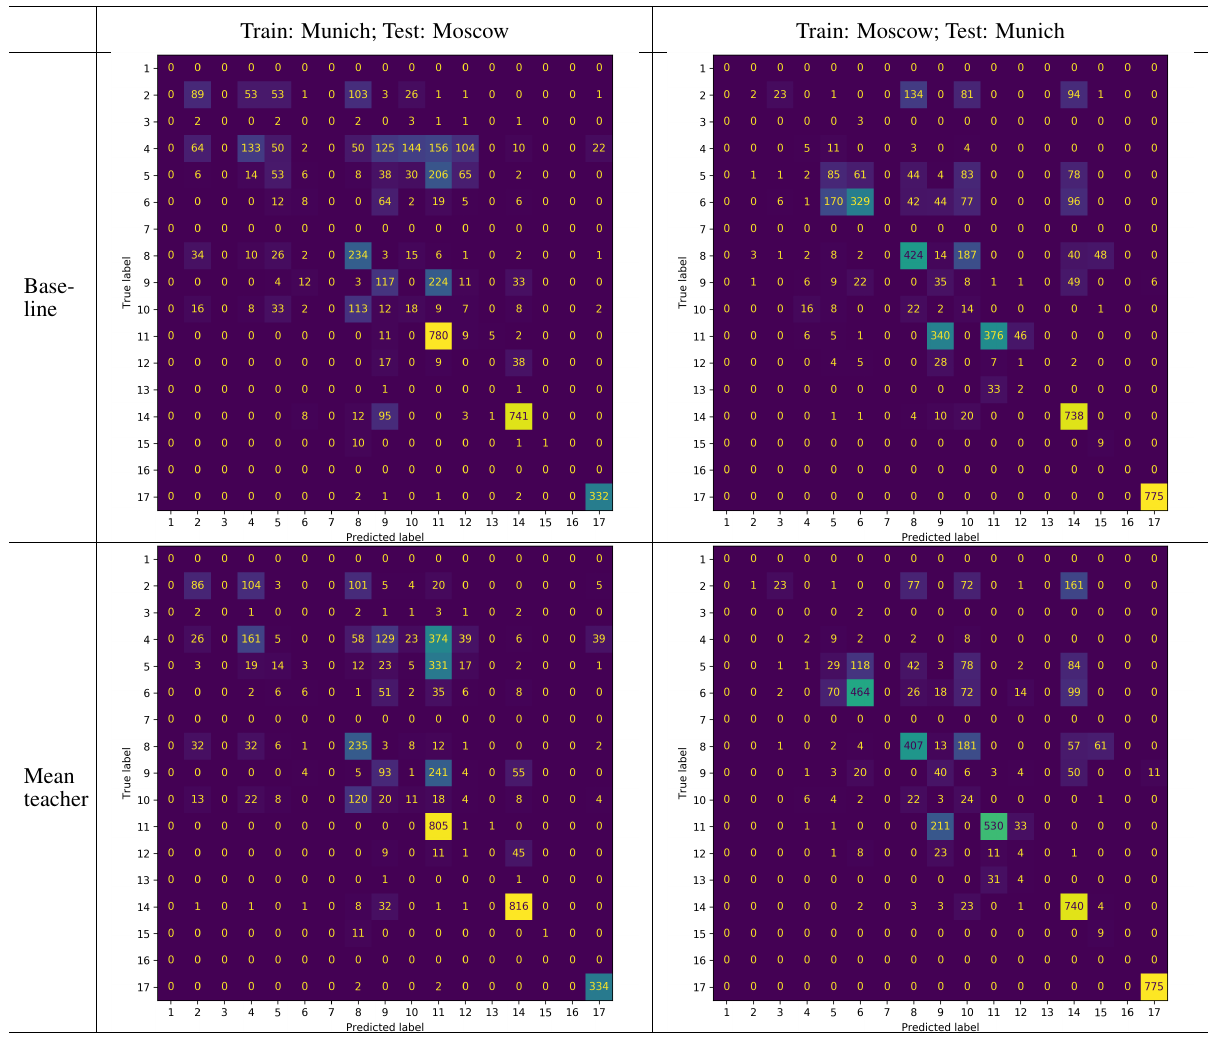
Figure 2. This figure shows the confusion matrices achieved by applying the baseline and the mean teacher model on the two cross-city scenarios. Each confusion matrix is a mean confusion matrix of ten repeated experiments, and the numbers in the confusion matrix are rounded into Integer. From left to right, top to bottom: the confusion matrix of the baseline which is trained with data of Munich and tested on data of Moscow; the confusion matrix of the baseline which is trained with data of Moscow and tested on data of Munich; the confusion matrix of the mean teacher model which is trained with data of Munich and tested on data of Moscow; the confusion matrix of the mean teacher model which is trained with data of Moscow and tested on data of